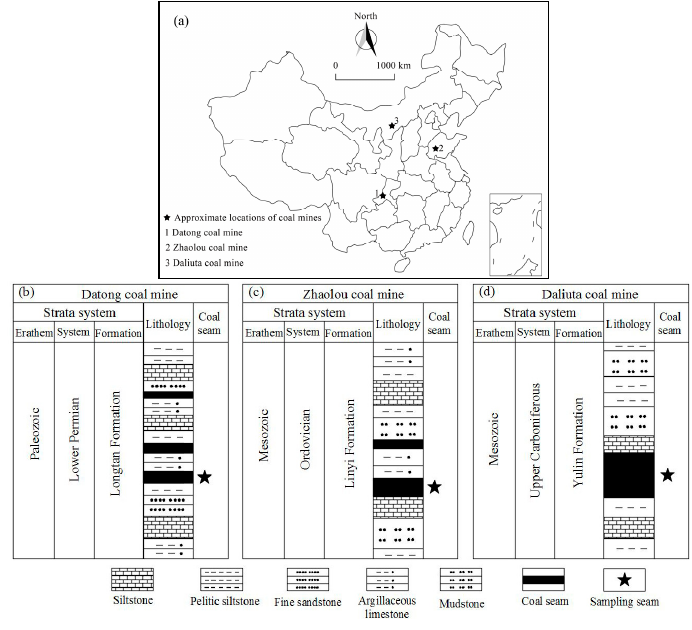
Figure 1. The information of coal specimens: ( a ) The locations, and ( b – d ) stratigraphic